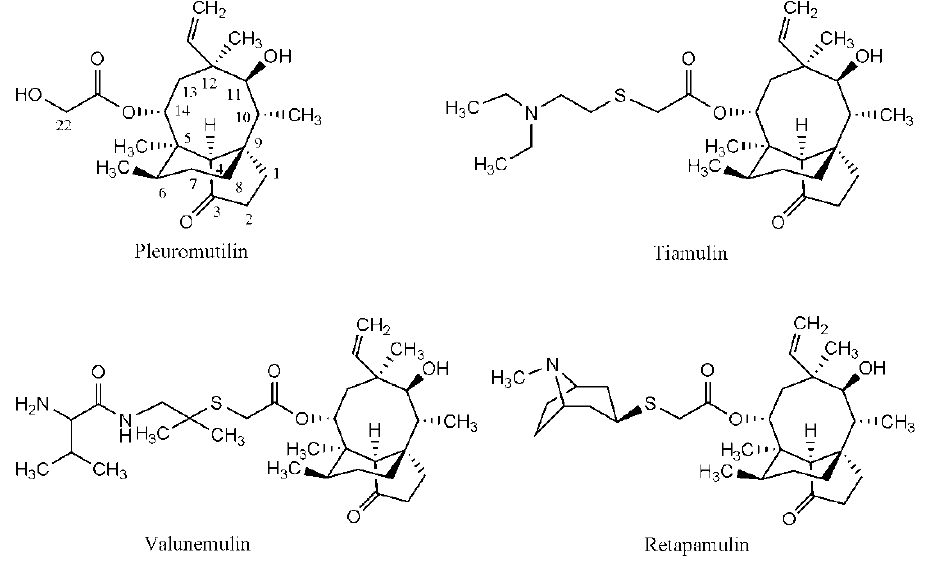
Figure 1. Structural formulas of pleuromutilin, tiamulin, valnemulin, and retapamulin.